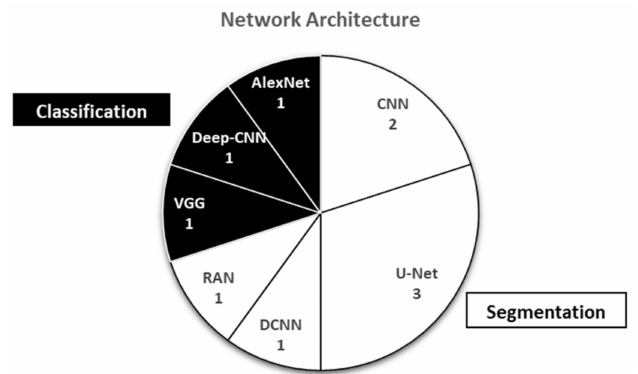
Figure 4. Various network architectures used in deep learning studies on muscle ultrasound